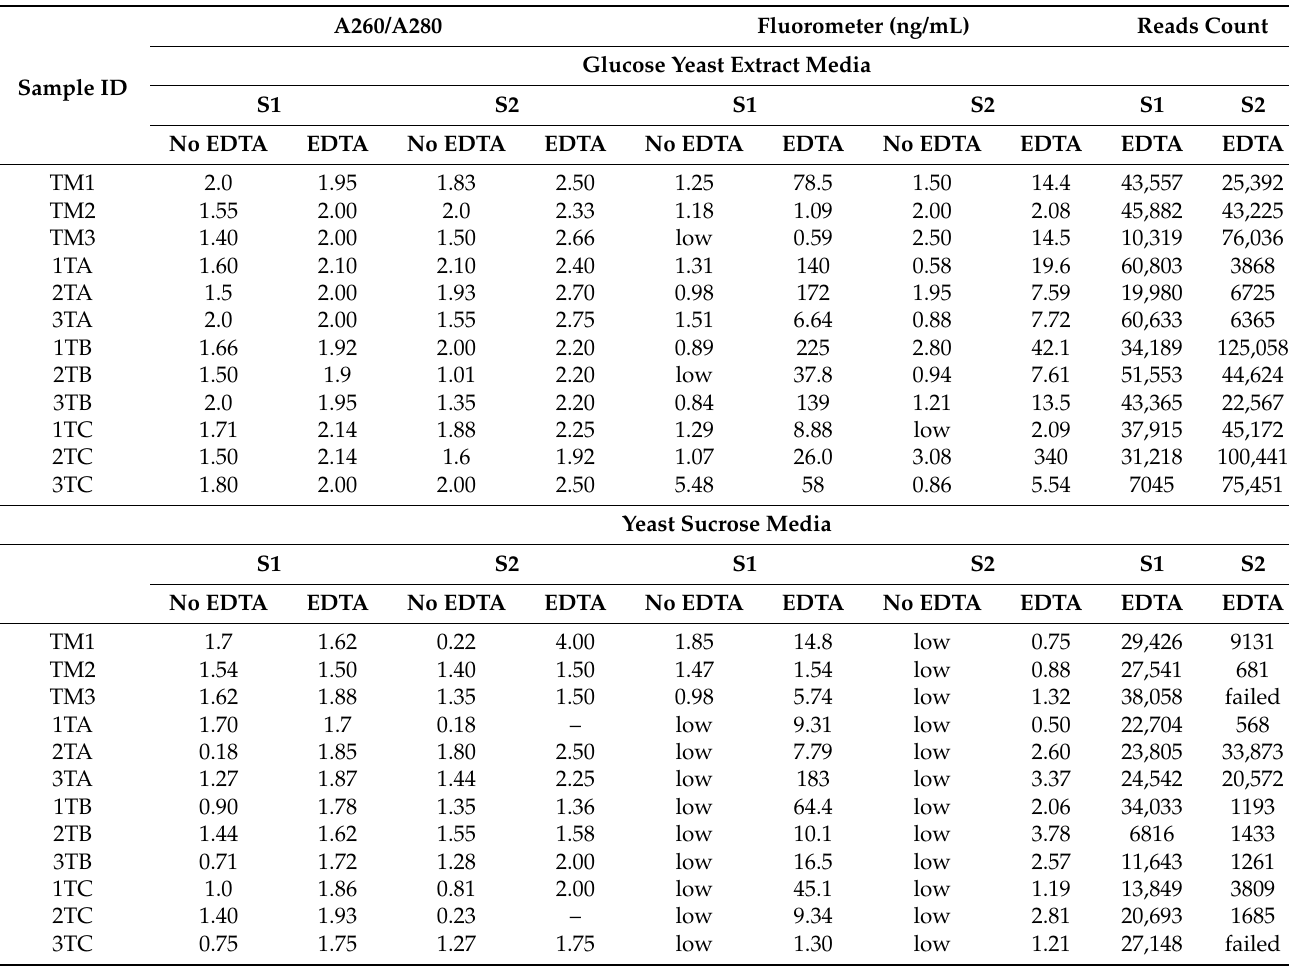
Table 3. Effectiveness of EDTA as chelating agent based on DNA purity, concentration, and successful amplification of ITS